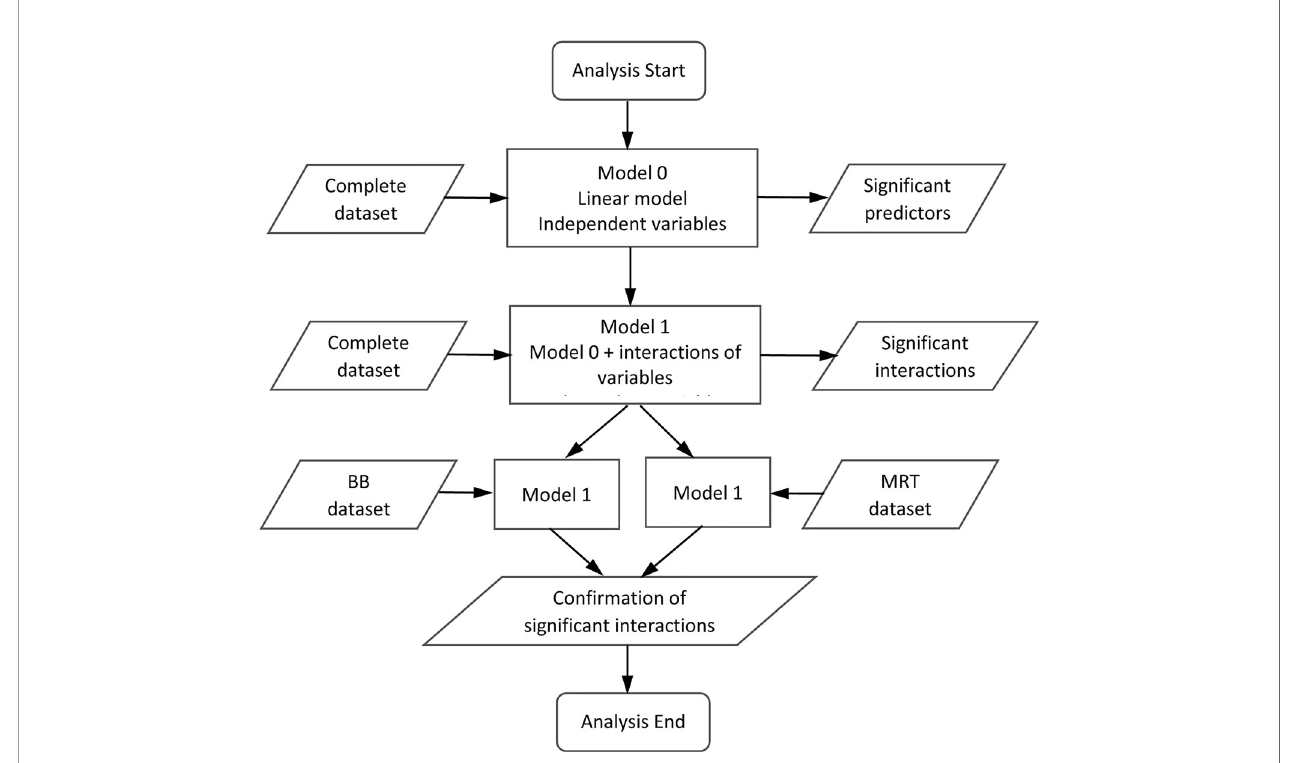
FIGURE 3 | Flow chart illustrating the sequence and logic of the analysis of the g -H2AX response. The fl ow chart maps out the steps taken to the modelling approach to test various assumptions and comparisons of the foci datasets analyzed in Tables 1 , 2 and outlined in the text.